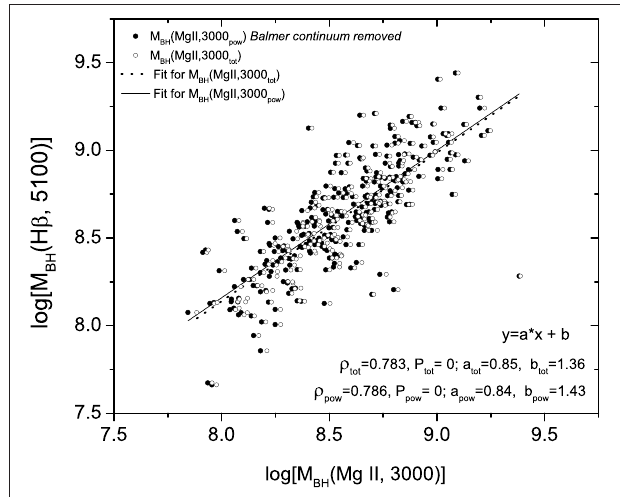
FIGURE 3 | The relation of the M BH [H β , L λ (5,100Å)] vs. M BH [ MgII , L λ (3,000Å)] before (index “tot,” open circles) and after the Balmer continuum subtraction (index “pow,” full circles). The corresponding correlation coefficients, P -values, and coefficients of the liner best-fit are also given.